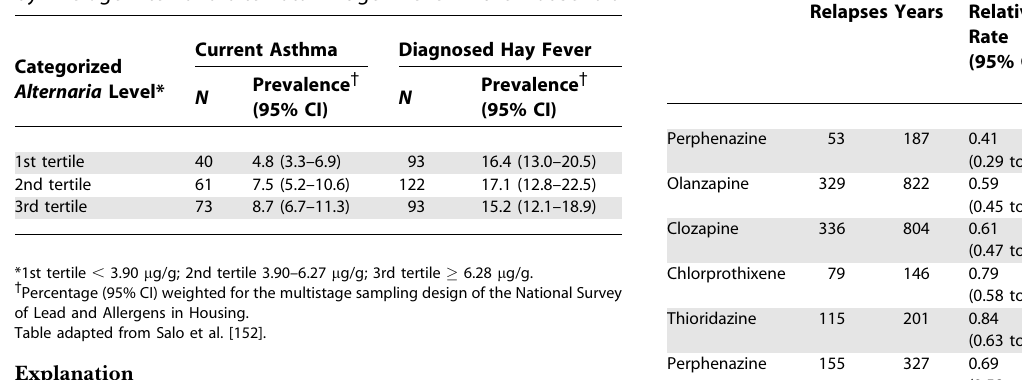
Table. Relative Rates of Rehospitalisation by Treatment in Patients in Community Care after First Hospitalisation due to Schizophrenia and Schizoaffective Disorder Treatment No. of Person- Crude Relapses Years Relative